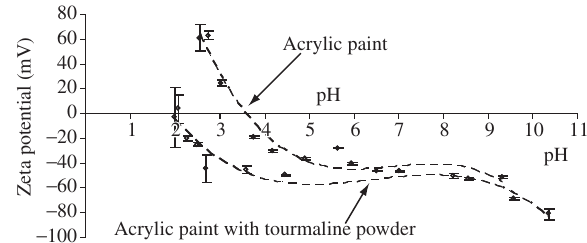
Figure 3. Zeta potential of a disk and a film of particles of black tourma-